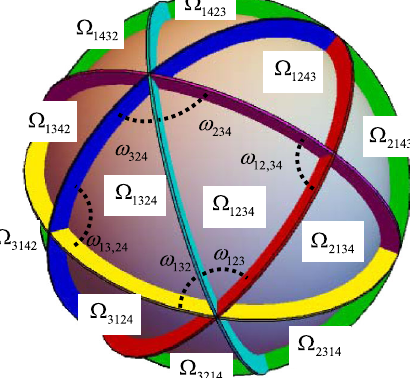
FIG. 1. The relative configuration space for four particles in the simplest case when all masses are the same, an example of the one-parameter mass family of the Coxeter group A 3 . The gray sphere represents an equipotential of the harmonic trap in the mass-normalized coordinates ð z 1 ; z 2 ; z 3 Þ . The six colored disks that intersect the plane represent the coincidence planes Z 12 (red), Z 13 (yellow), Z 14 (green), Z 23 (cyan), Z 24 (blue), Z 34 (magenta). Twelve sectors are visible and are labeled by Ω , where p is the p order of the four particles. For two sectors Ω 1234 and Ω 1324 , the three angles are also